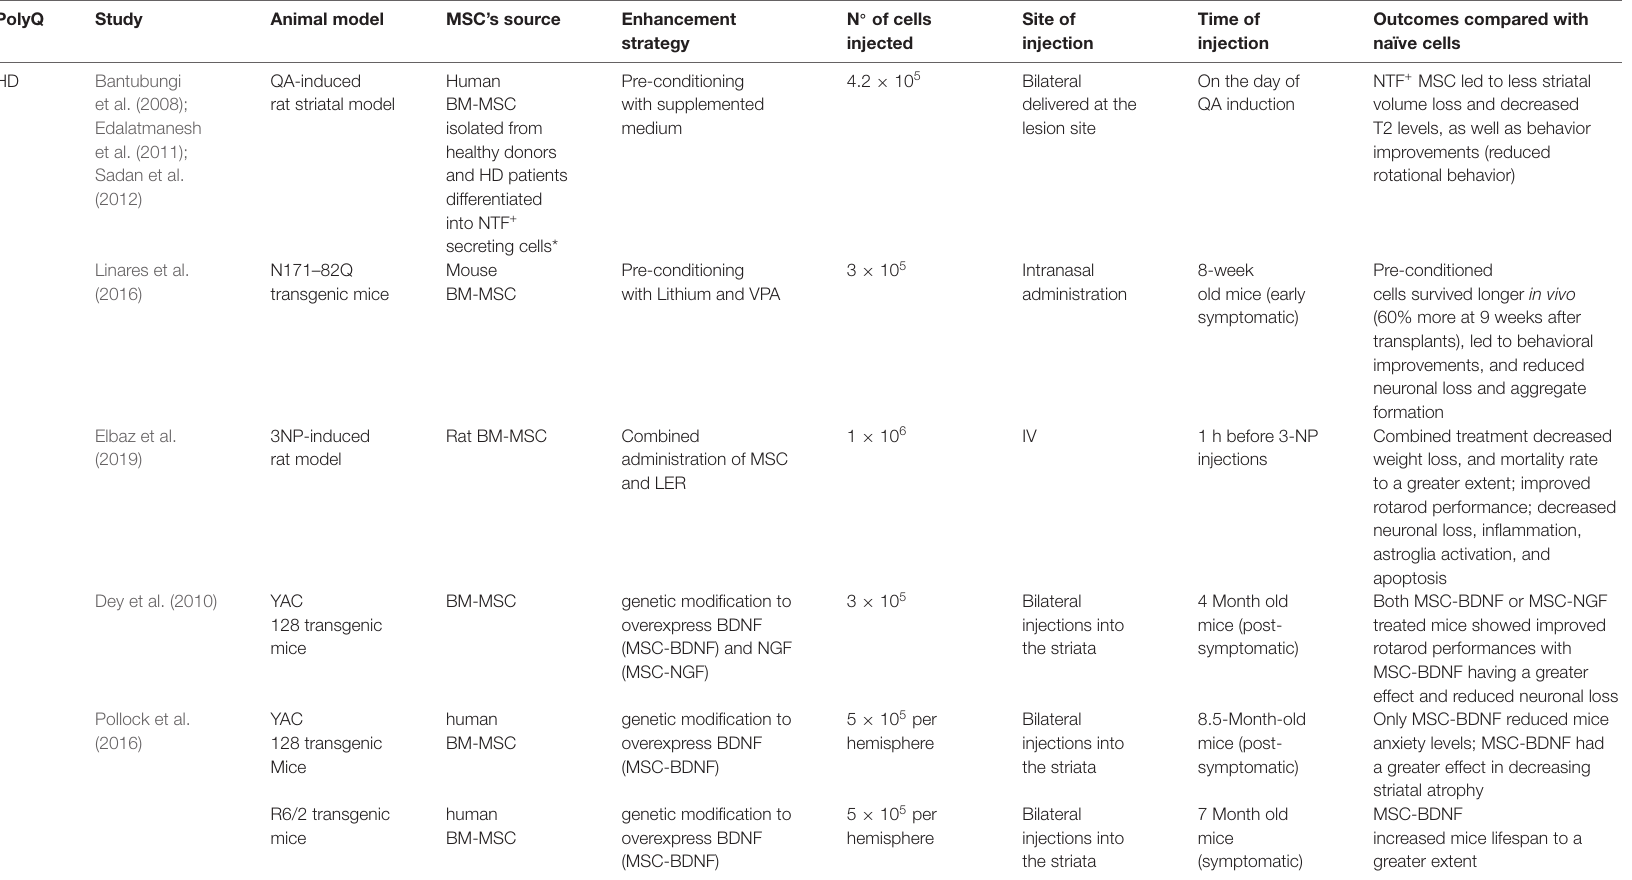
TABLE 3 | Summary of results using modified-MSCs in PolyQ diseases in comparison to naive cells—evidence from pre-clinical